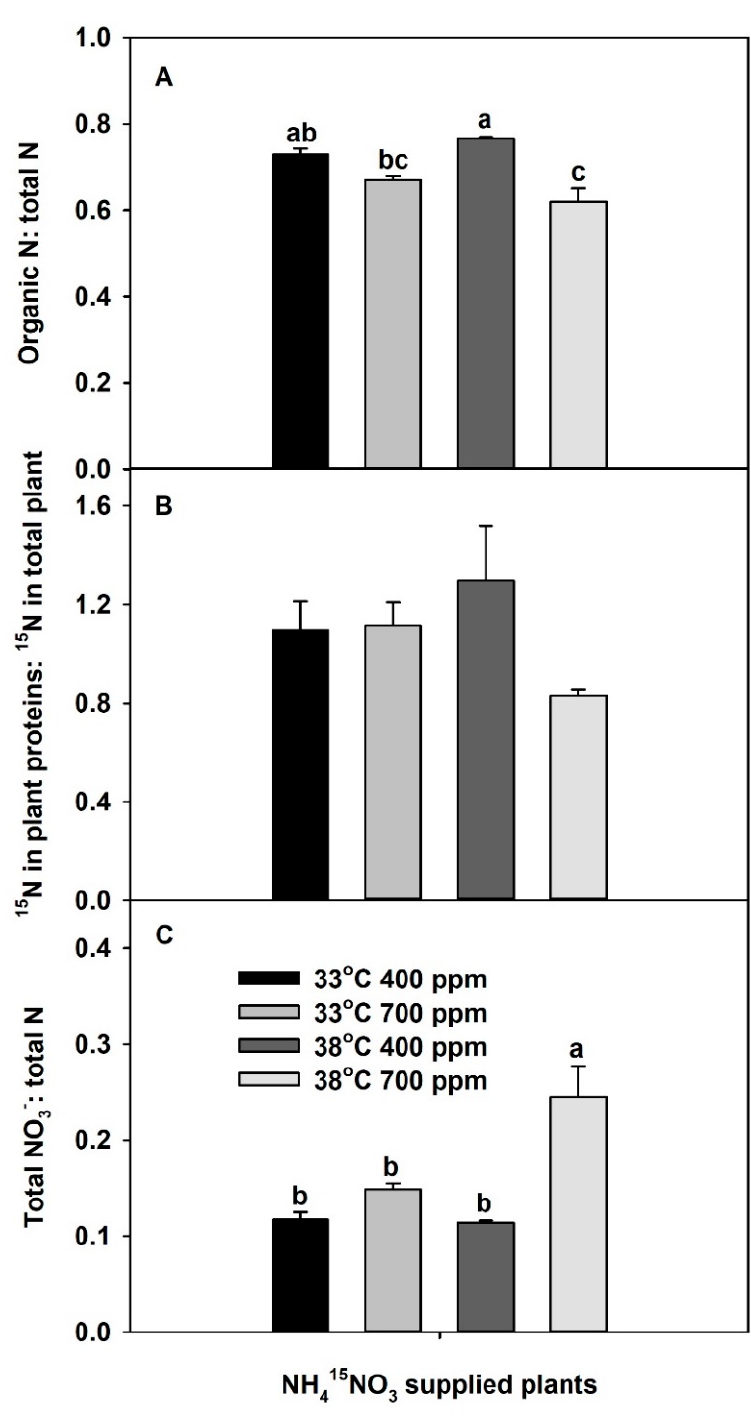
Figure 4. Effects of ambient (400 ppm) vs. elevated (700 ppm) CO 2 and near-optimal (33 ◦ C) vs. chronic warming (38 ◦ C) day-time temperatures on ( A ) organic N: total N, ( B ) 15 N in plant proteins: 15 N in total plant, and ( C ) total NO 3 − : total N ratios of Solanum lycopersicum , labeled for 3 days with 1 mM NH 415 NO 3 and grown for 21 days. Each bar represents mean (n = 5) + 1 SEM. Within each panel, bars not sharing the same letters are significantly different ( p < 0.05, Tukey’s test); no letters are shown if there are no differences.